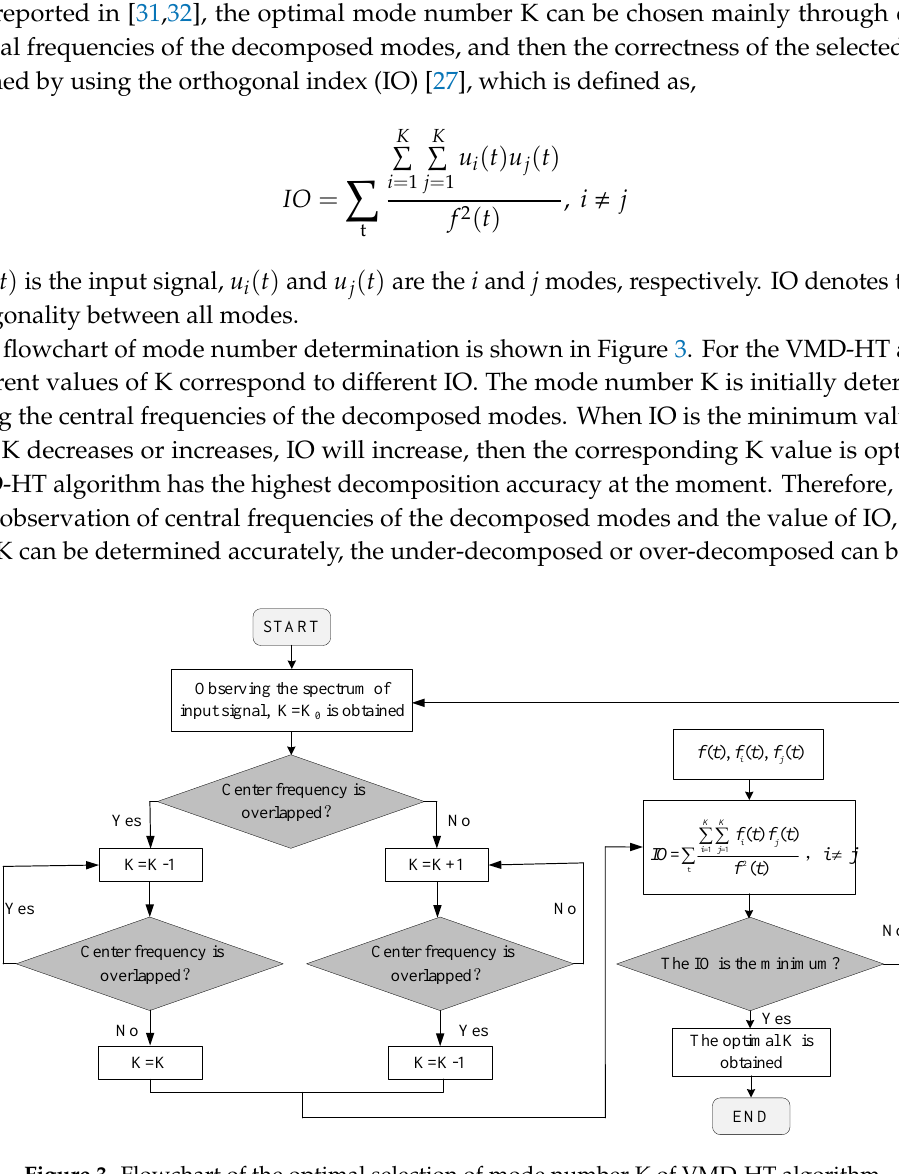
Figure 3. Flowchart of the optimal selection of mode number K of VMD-HT algorithm.